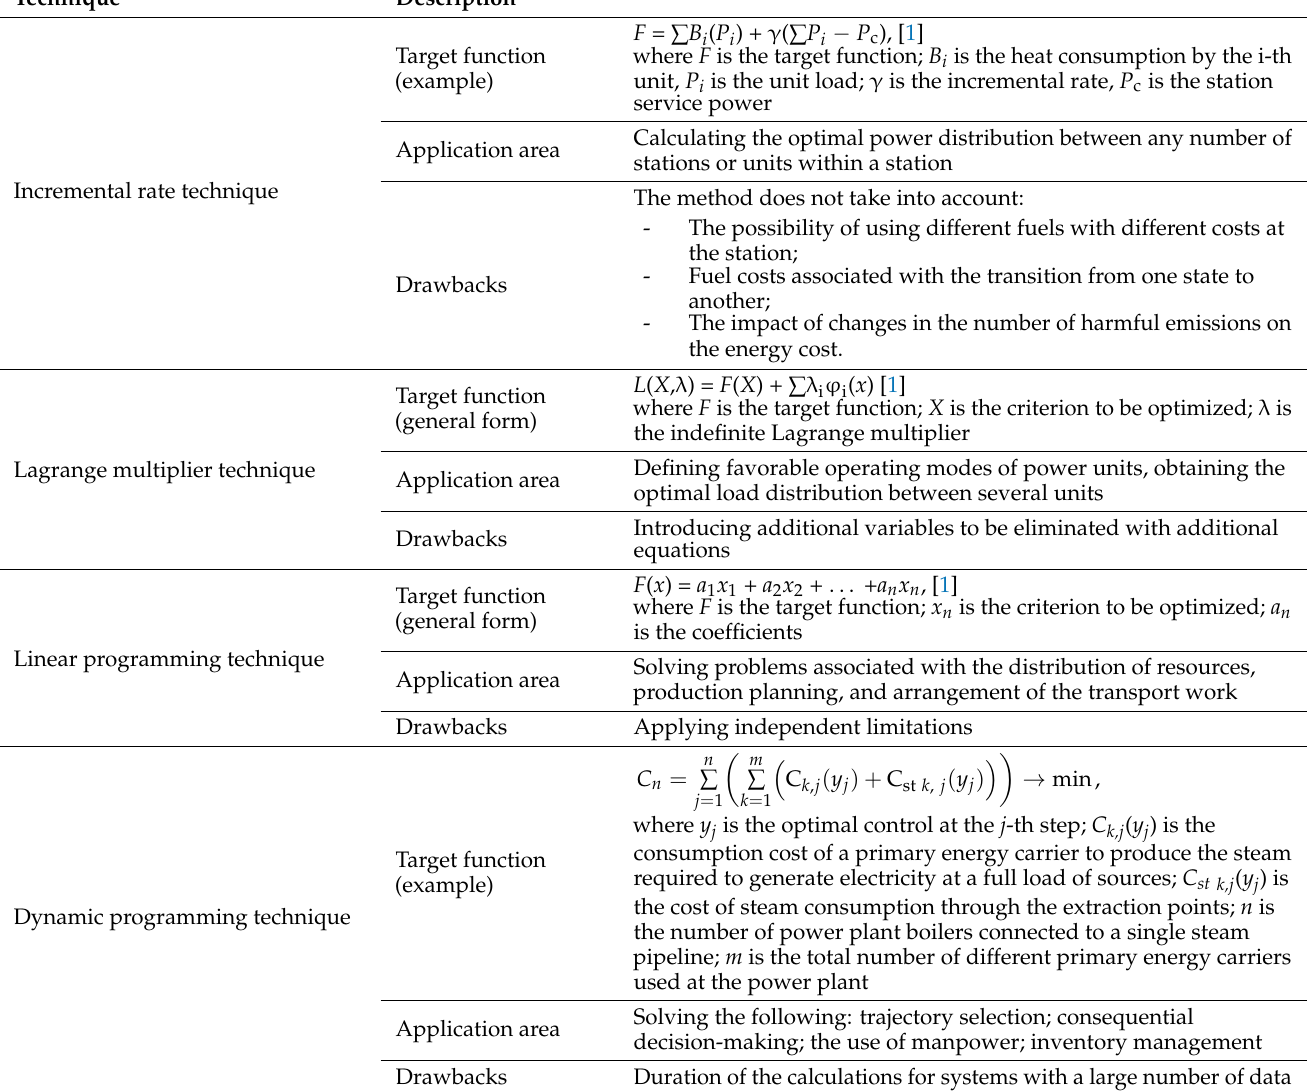
Table 1. Optimization